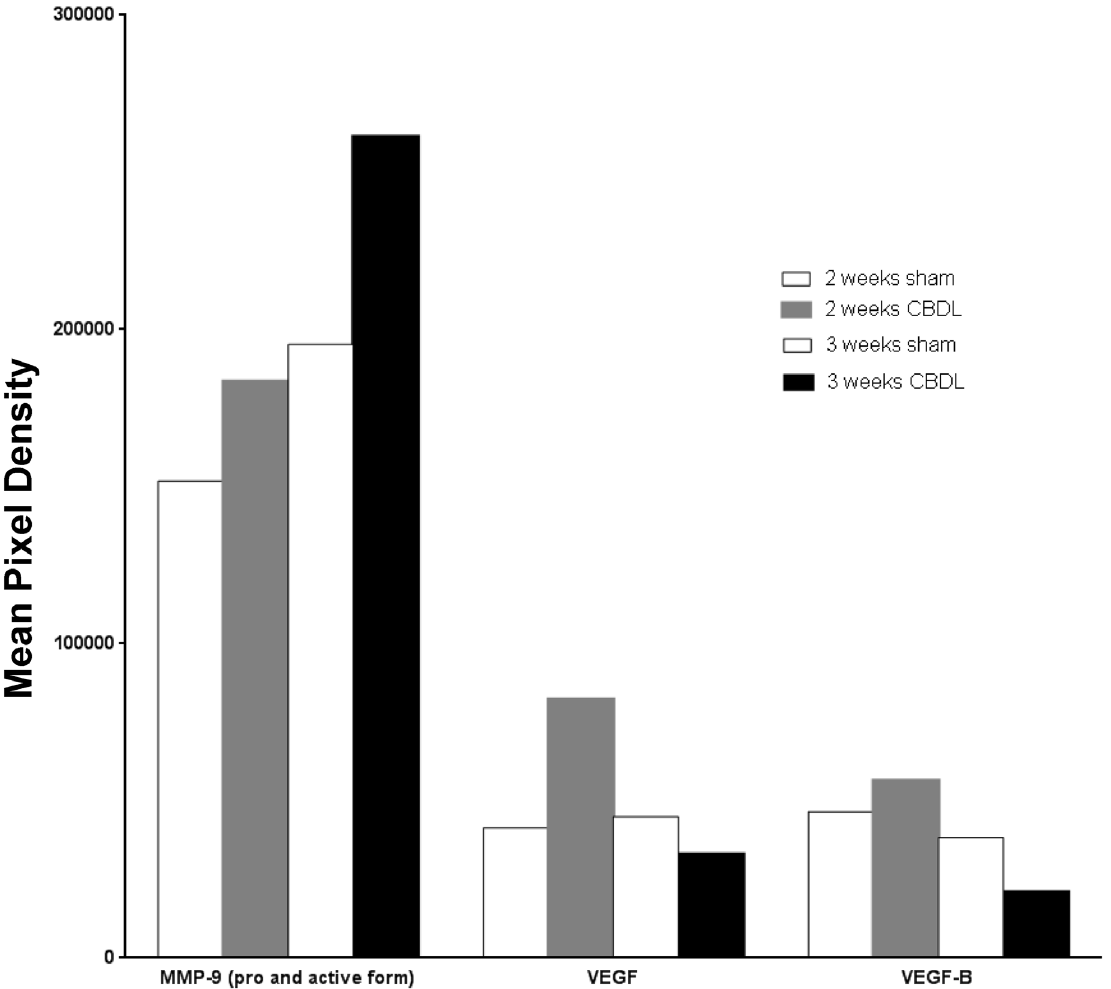
Figure 7. Protein array analysis of serum from common bile duct ligated (CBDL) and sham operated mice. Mean pixel density of representative proteins analyzed by protein array in serum isolated from CBDL and sham operated mice.